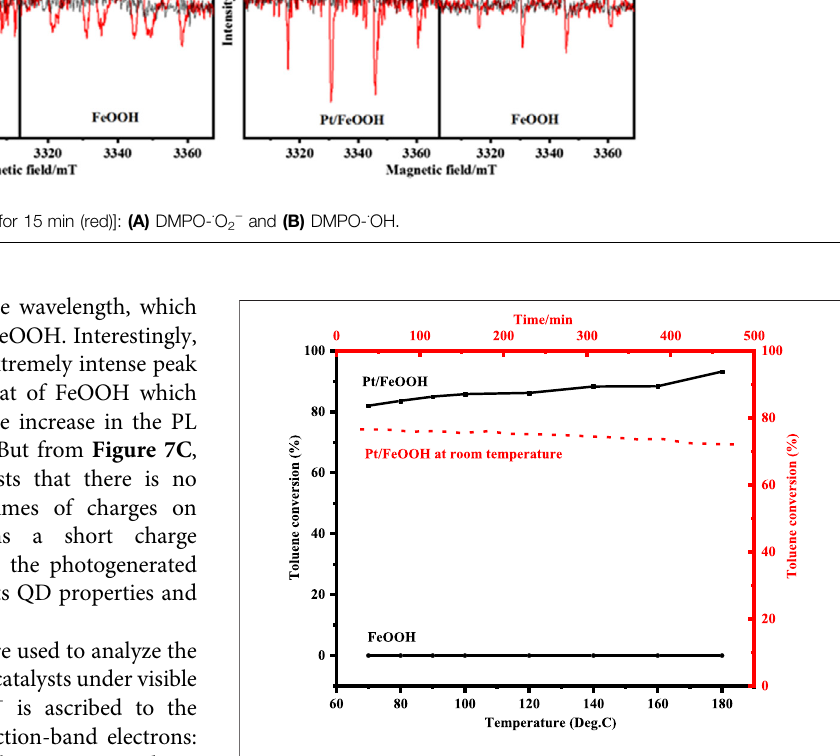
FIGURE9| Temperaturedependenceoftoluene conversion ofsamples and time dependence of toluene conversion of Pt/FeOOH at room